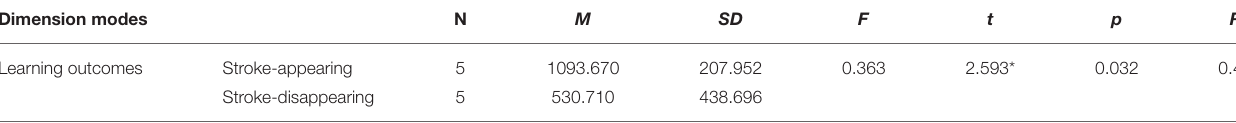
TABLE 3 | Learning outcomes of the different COS modes. Dimension modes N M SD Learning